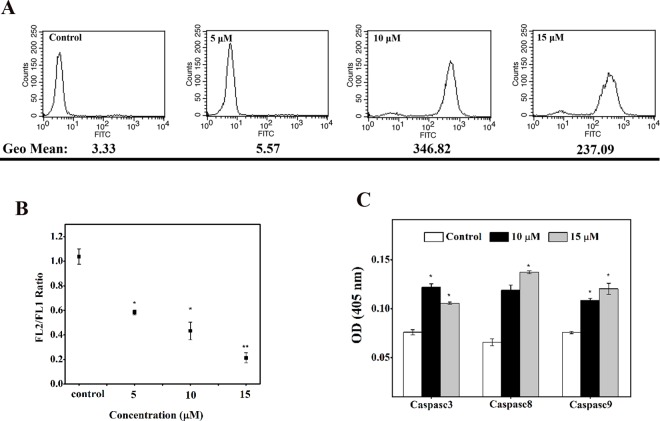
HPRP-A2-induced mitochondrial membrane potential.(A) BGC-823 cells were treated for 1 h and the generation of reactive oxygen species (ROS) was analyzed by FACS to quantitatively compare the fluorescence intensity (in Geomean) at various concentrations. (B) After 1 h treatment, the ratio of FL2-H/FL1-H decreased, indicating a reduction of MMP. (C) BGC-823 cells were treated with HPRP-A2 (10 and 15 μM) for 24 h and then levels of caspase activities were measured. Data are expressed as mean ± SD of three independent experiments. Statistical analysis compared the HPRP-A2 treatment group with the control groups (*P < 0.005; **P <0.001).